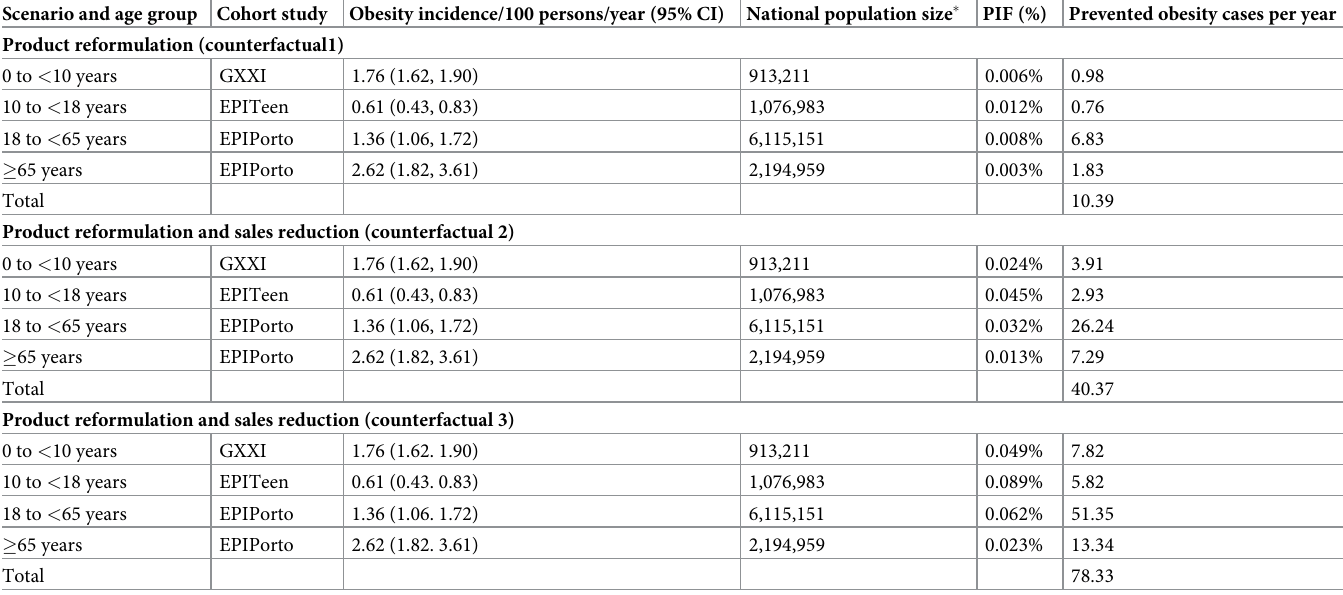
Table 2. Potential impact fraction (PIF) and prevented obesity cases due to the decrease in sugar content of sugar-sweetened beverages (counterfactual 1) and due to decreases in sugar content and consumption volume (counterfactuals 2 and 3). Scenario and age group Cohort study Obesity incidence/100 persons/year (95% CI) National population size � PIF (%) Prevented obesity cases per